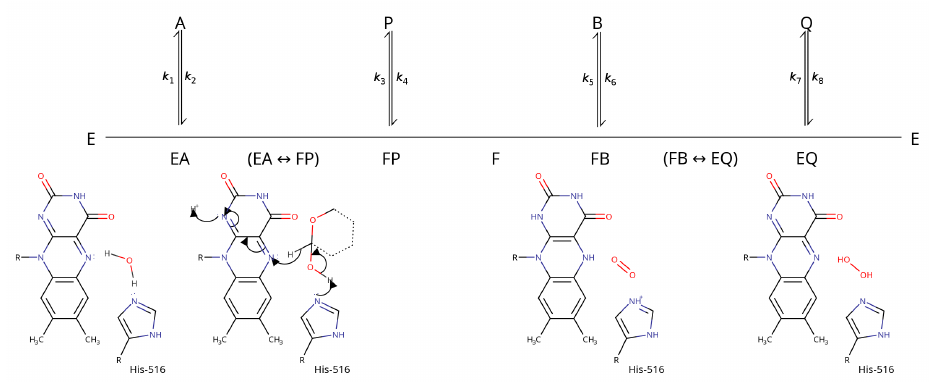
Figure 4. A scheme illustrating the overall glucose oxidase reaction. A indicates glucose, P indicates glucono- δ -lactone, B represents O 2 , Q represents H 2 O 2 , E represents the oxidized form of GOx bound to FAD, and F stands for the reduced form of GOx bound to FADH 2 . The individual components of the reaction are illustrated below the scheme; from left to right they are reduced GOx (E), the most likely mechanism of the GOx reduction half-reaction (EA ↔ FP), the GOx–O 2 complex (FB) and the GOx–H 2 O 2 complex